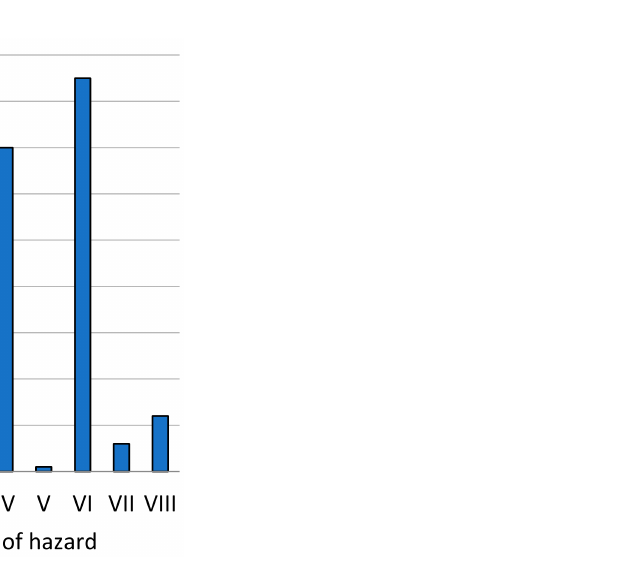
Figure 5. Frequency of various types of threats associated with the occurrence of wild boars in the city of Olsztyn. Source: own elaboration.